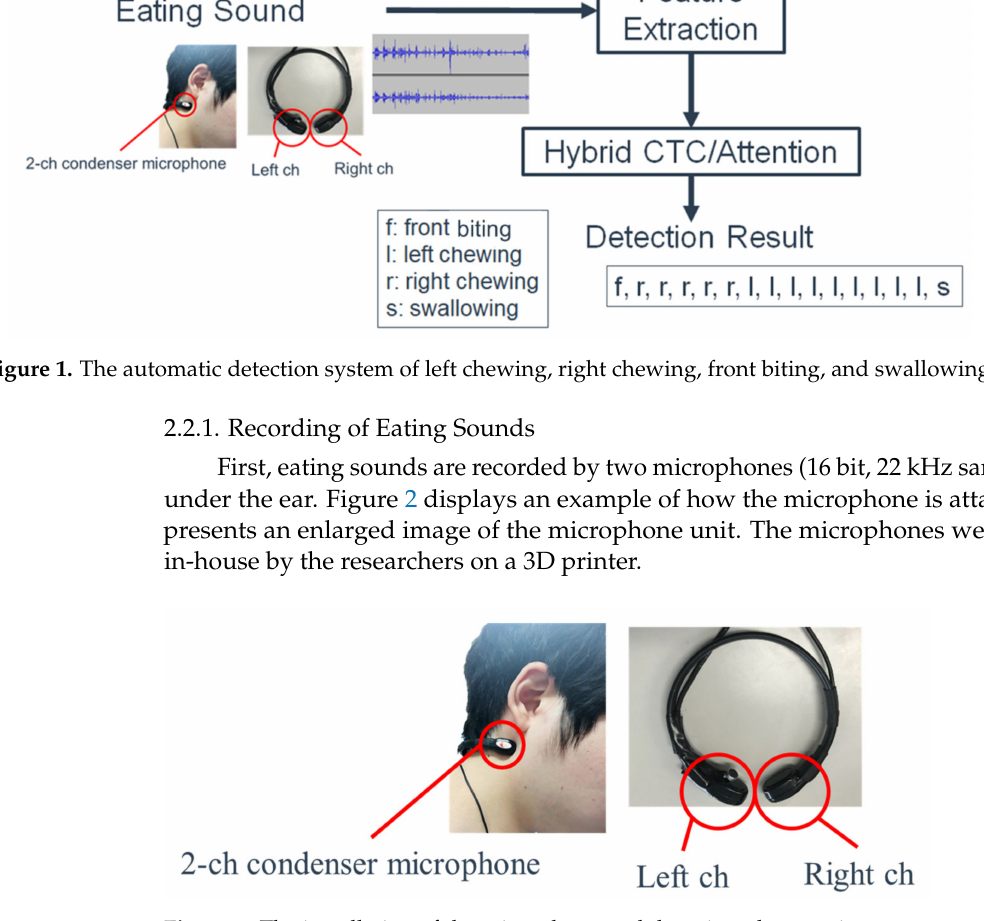
Figure 2. The installation of the microphone and the microphone unit.